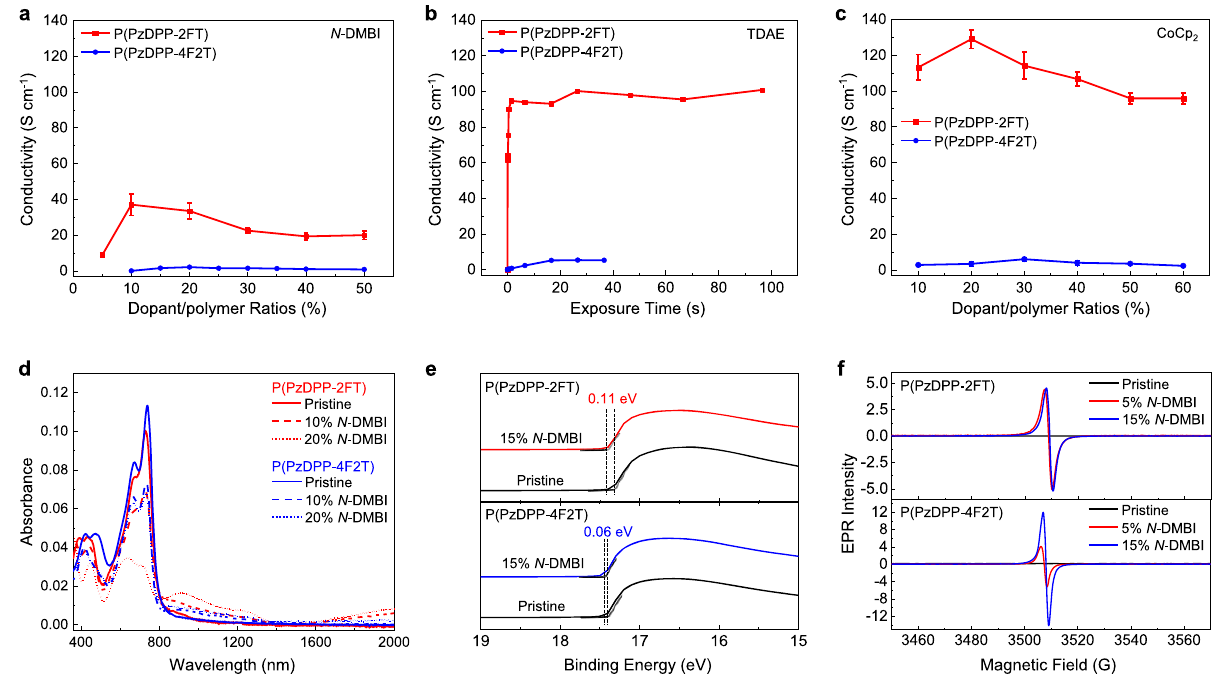
Fig. 3 N -doped electrical conductivities and doping ef fi ciency comparison. a Electrical conductivities at different N -DMBI/polymer ratios. b Electrical conductivities after different exposure times in TDAE vapor. c Electrical conductivities at different CoCp 2 /polymer ratios. The error bars are determined according to 2% measurement errors. d Absorption spectra of the pristine and N -DMBI-doped P(PzDPP-2FT) and P(PzDPP-4F2T) fi lms. e UPS binding energy of the pristine and 15% N -DMBI-doped fi lms. f EPR signals of the pristine and N -DMBI-doped fi lms at different dopant/polymer